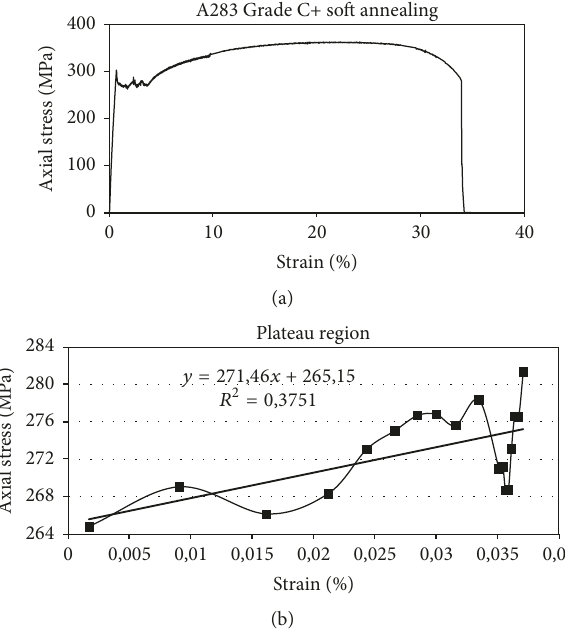
Figure 6: (a) 𝜎 - 𝜀 curve for A283 Grade C steel. (b) The plateau region of 𝜎 - 𝜀 curve [7].